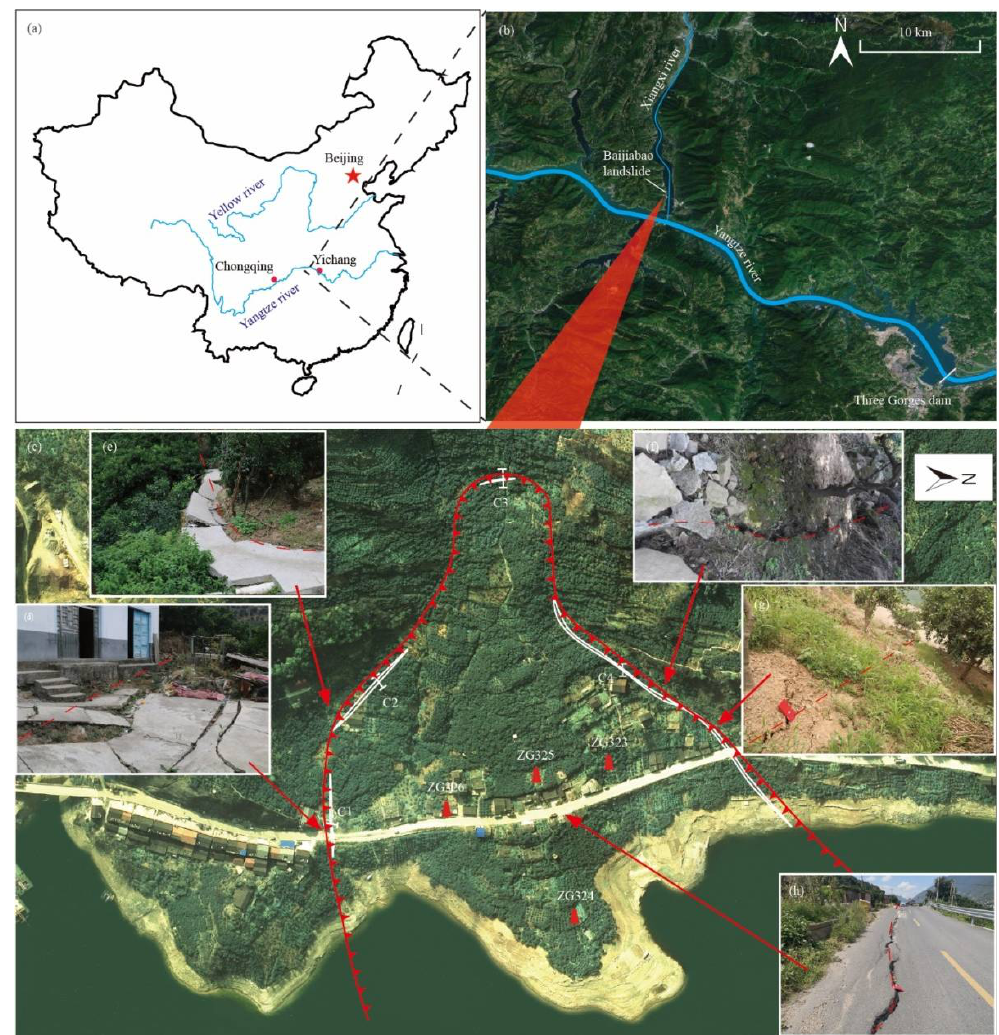
Figure 2. Location and oblique view of the Baijiabao landslide. ( a ) Study area location; ( b ) Landslide location; ( c ) Overall view of the Baijiabao landslide; ( d ) Crack along right boundary; ( e ) Crack on the footpath; ( f ) Crack on the farmland; ( g ) Crack along the left boundary; ( h ) Transverse crack on the road.